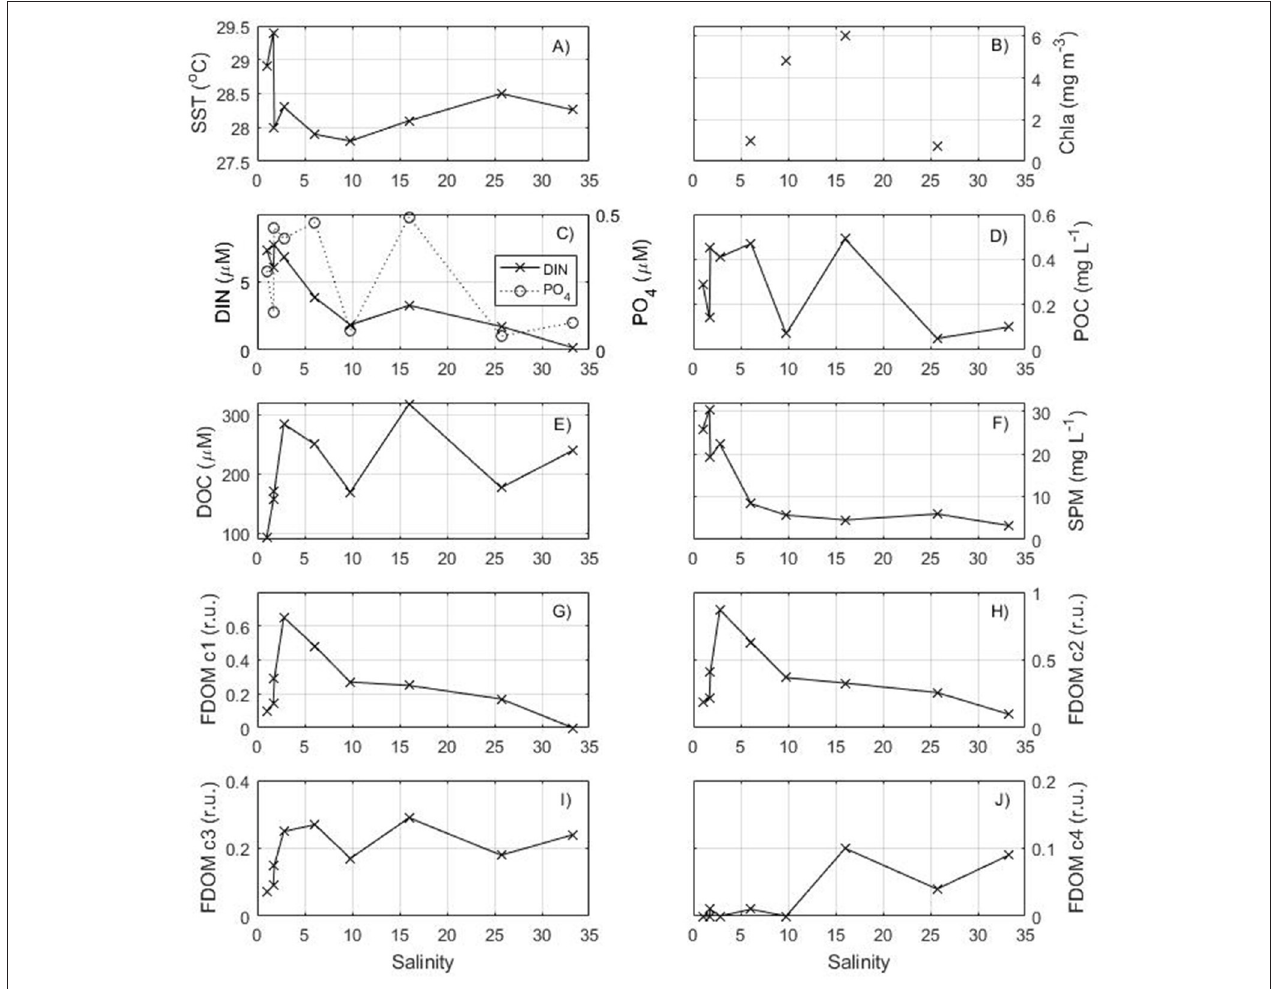
FIGURE 3 | Distribution of surface (A) temperature, (B) chlorophyll a from MODIS, (C) DIN and phosphate, (D) POC, (E) DOC, (F) Suspended Particulate Matter, (G) C1 component of FDOM, (H) C2 component of FDOM, (I) C3 component of FDOM, (J) C4 component of FDOM as a function of salinity for the transect in May